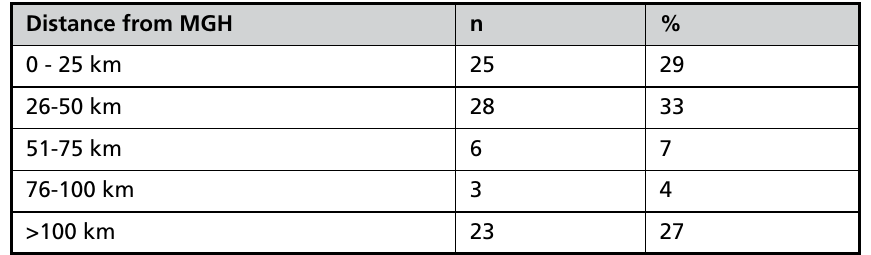
table 2. Patients (n=85) with distances from hospital